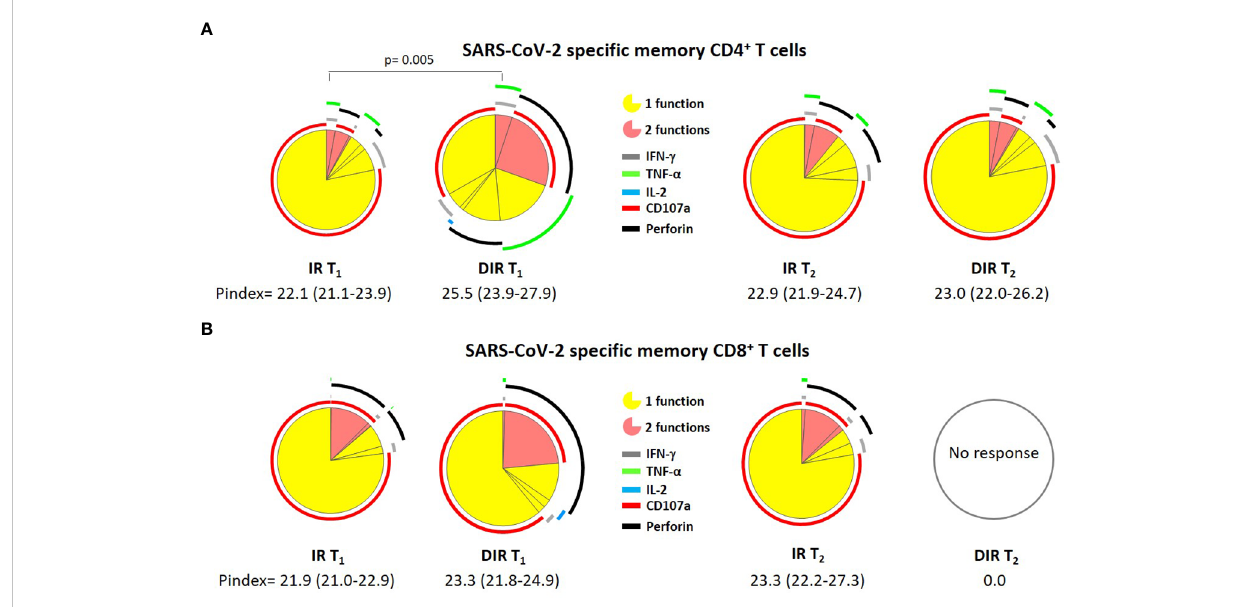
FIGURE 8 Pie charts representing (A) SARS-CoV-2 S – speci fi c memory CD4 + and (B) CD8 + T cell polyfunctionality. Each sector represents the proportion of S- speci fi c CD4 + T cells producing 1 (yellow) or 2 (red) functions. Arcs represent the type of function (IFN- g , IL-2, TNF- a , CD107a, and perforin) expressed in each sector. IR, immune responders. DIR, discordant immune response. T 1 and T 2 a median of 33 and 166 days after the second ARN vaccine